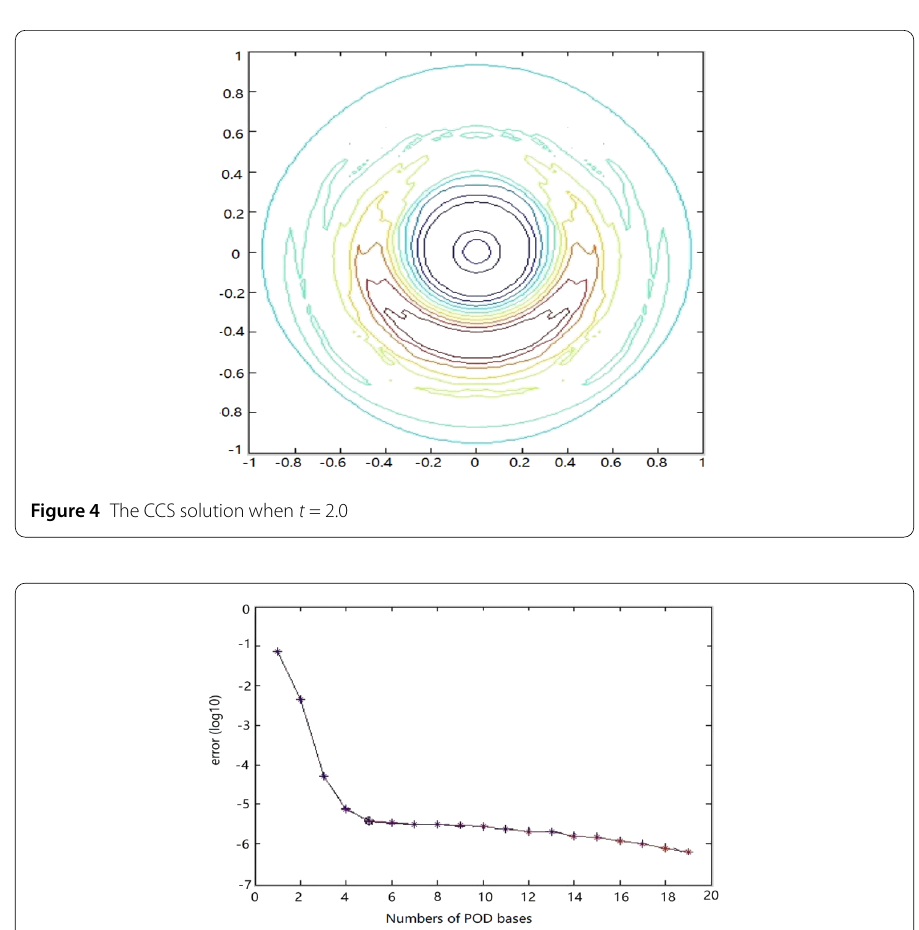
Figure 5 The errors between the ROECS solutions with different number of POD bases and the CCS solution when t =